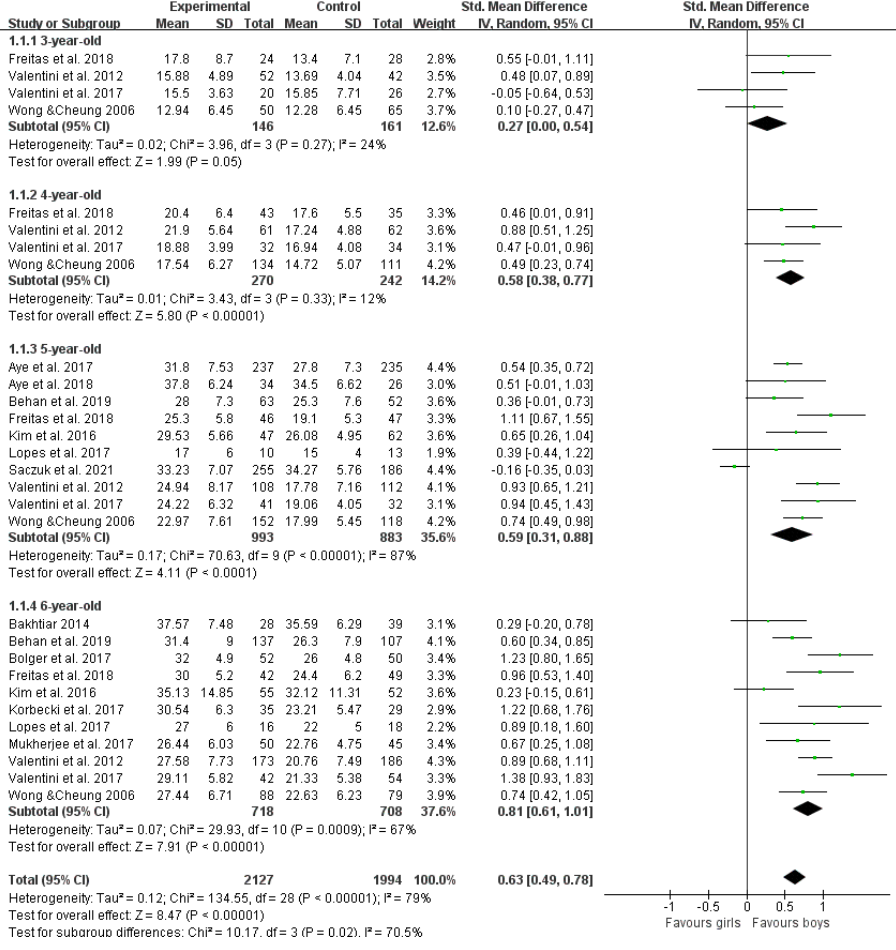
Figure 5. Forest plot of object control skills (age subgroups)